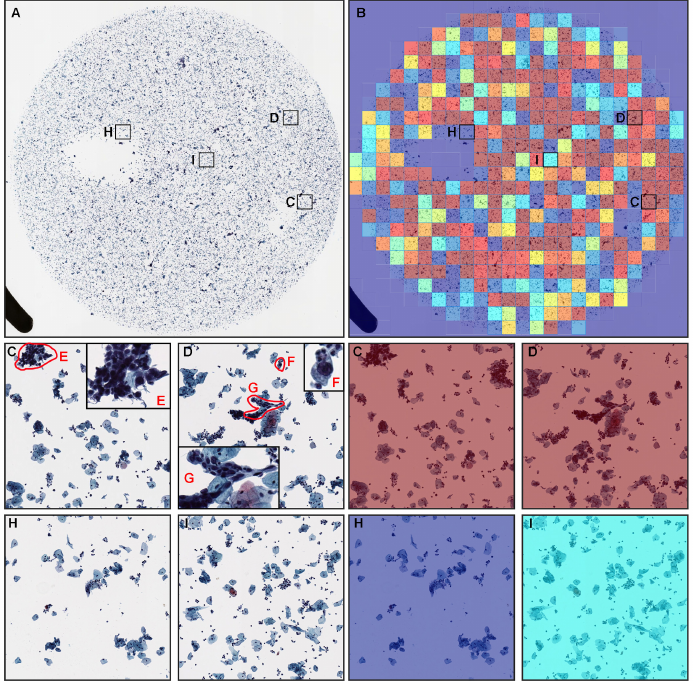
Figure 4. A representative example of neoplastic true positive prediction outputs on a liquid-based cytology (LBC) case from test sets. In the neoplastic whole-slide image (WSI) of LBC specimen ( A ), the heatmap image ( B ) shows a true positive prediction of neoplastic epithelial cells in high probability tiles ( C , D ), which correspond, respectively, to neoplastic epithelial cells ( E – G ) equivalent to HSIL (high-grade squamous intraepithelial lesion). On the other hand, in low probability tiles ( H , I ) of the same heatmap image ( B ), there are no evidence of neoplastic